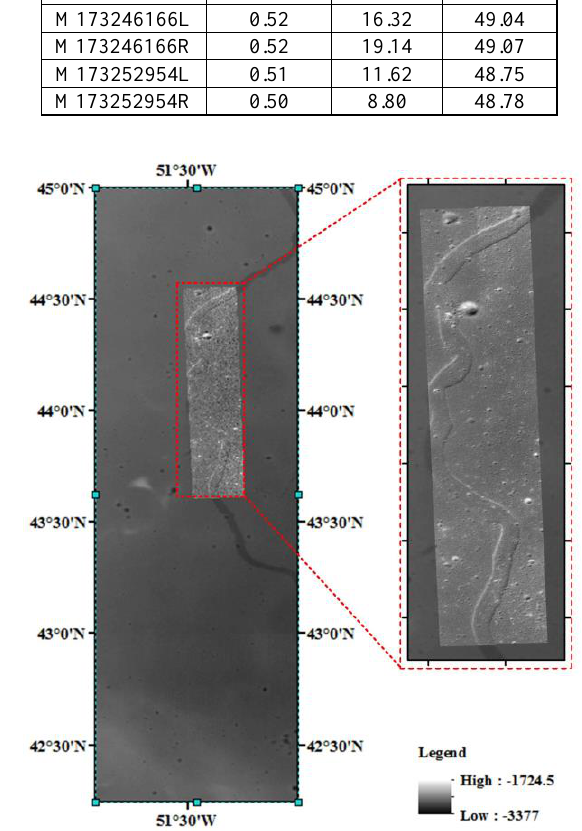
Figure 4. The two NACs of product M173246166 overlaid on the SLDEM. The images mainly cover part of a long lunar Rille.